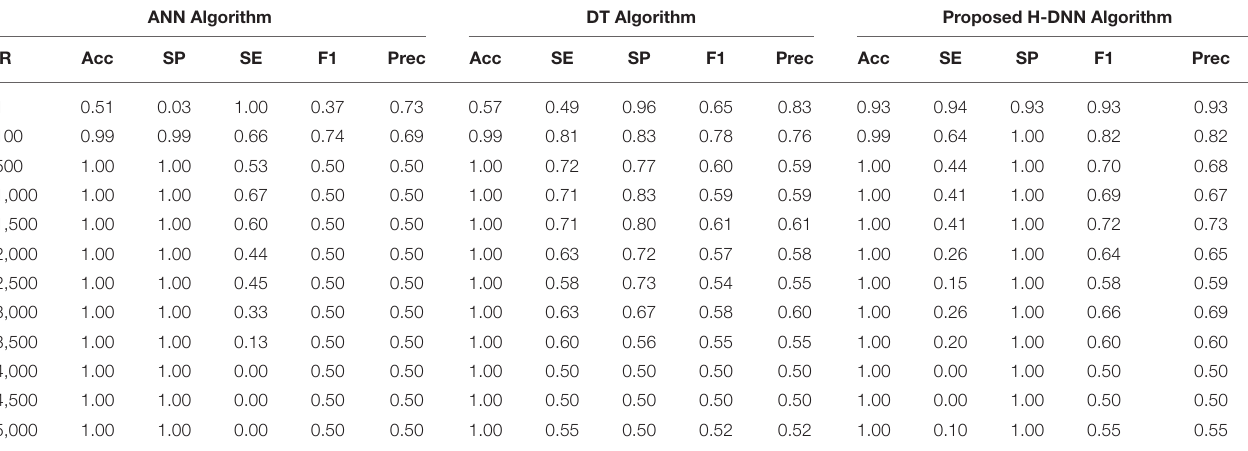
TABLE 4 | Experimental results using animal dataset.